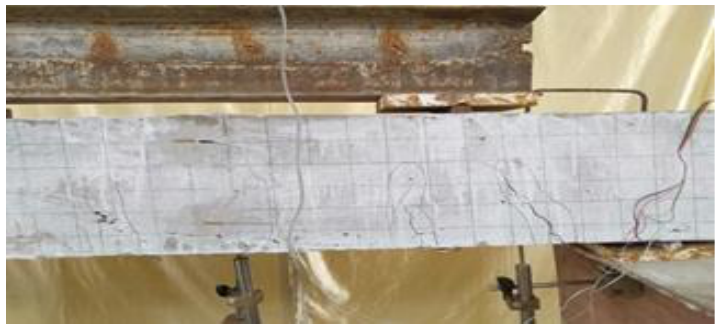
Figure 16. Crack pattern for Beam 3.